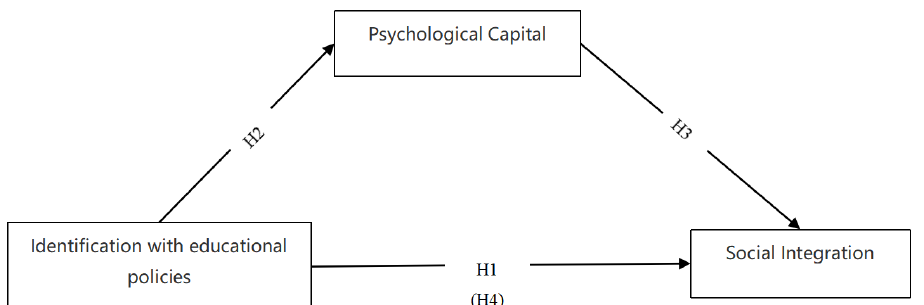
Figure 1. Hypothesized model.